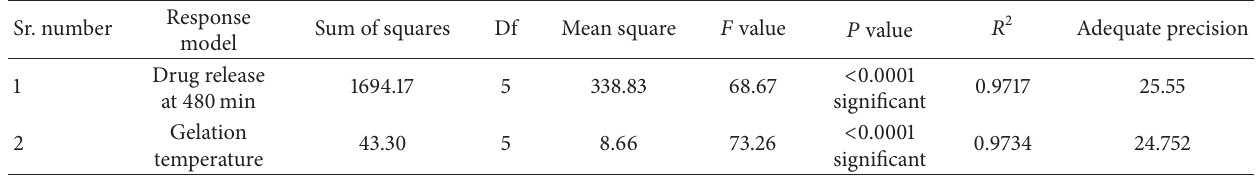
Table 6: ANOVA analysis.